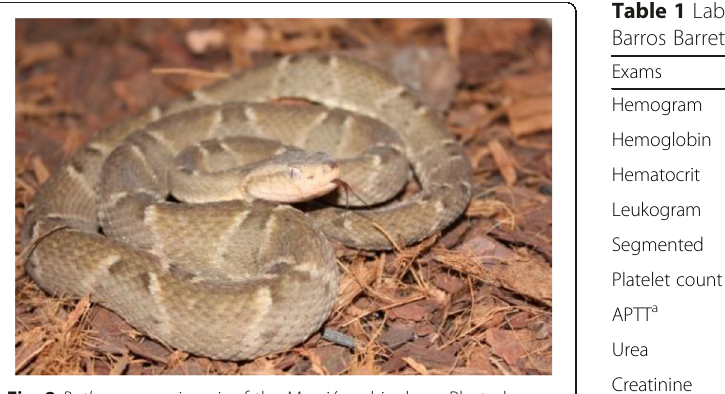
Fig. 2 Bothrops marajoensis of the Marajó archipelago. Photo by Leandro